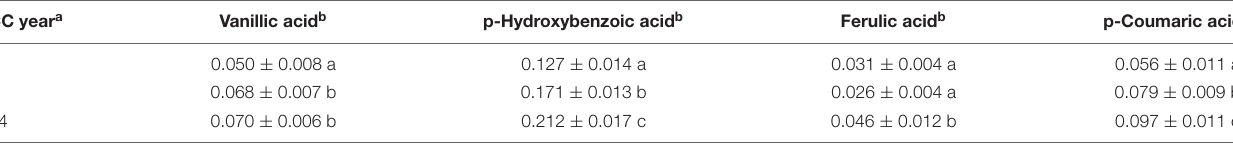
TABLE 2 | Relative content of phenolic acids from rhizosphere soils in fields with alfalfa continuous cropping.